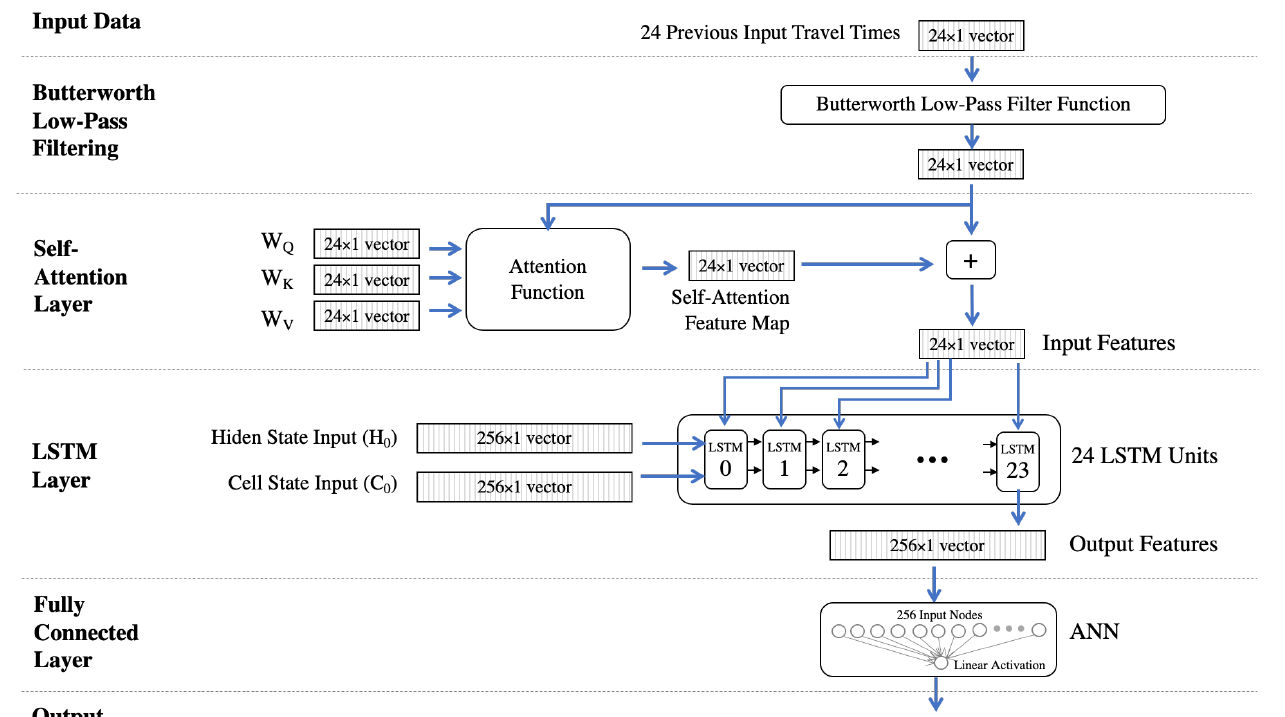
Figure 6. The architecture of our travel time prediction model.